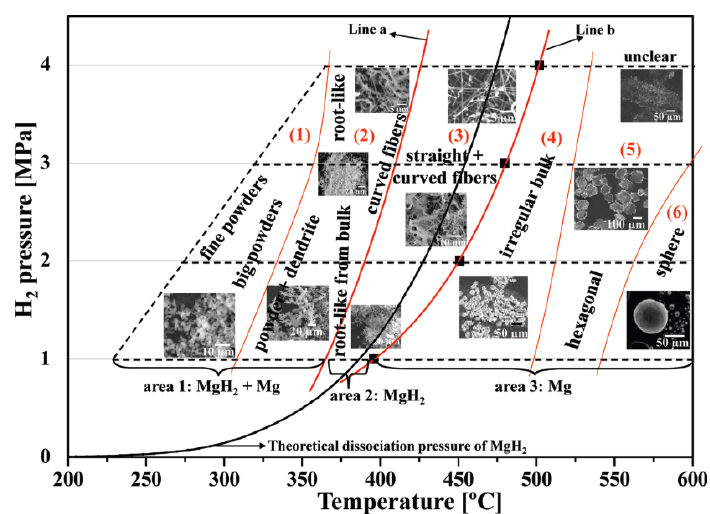
Figure 10. Simplified morphology and composition distributions of the deposited products at dif- ferent deposition temperatures and H 2 pressures plotted in the P-T diagram of MgH 2 [135]. Copy- right 2010 ACS Publications.